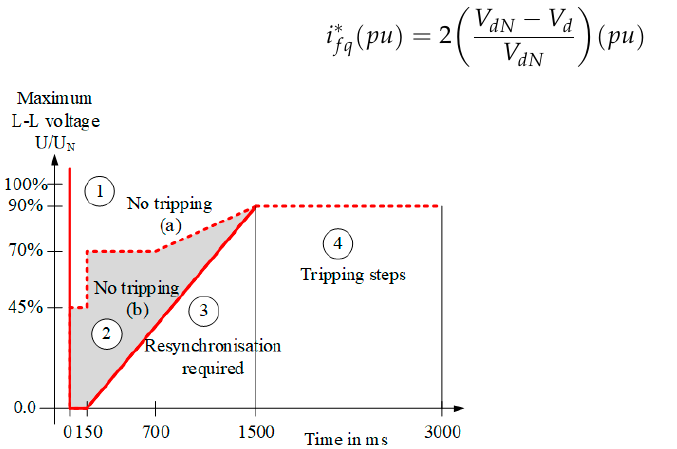
Figure 1. Requirements of low-voltage tolerance for WTGs by E.ON. (U denotes the system voltage, U N denotes the system nominal voltage).